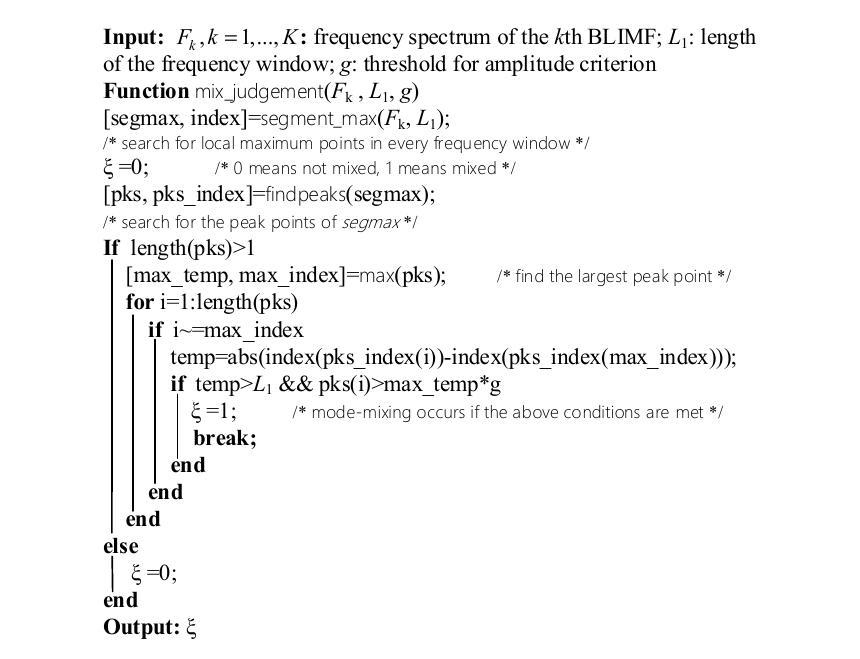
Algorithm 1: Pseudo-code of the proposed mode-mixing judgement method Algorithm 1 : Pseudo-code of the proposed